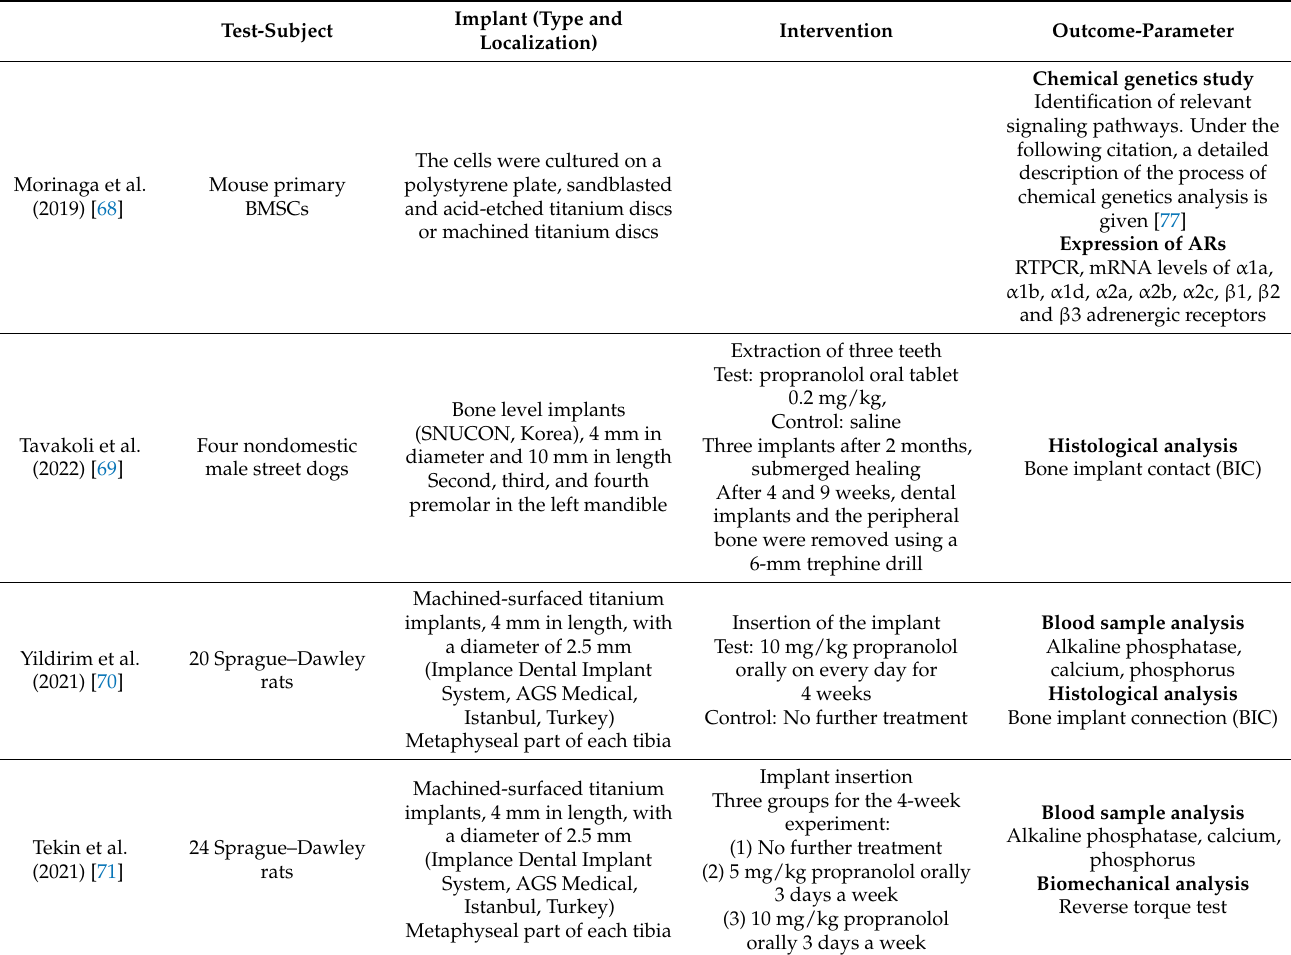
Figure 2. Risk of bias assessment according to the SYRCLE risk of bias tool [41]. H: High-risk; L: Low-risk; U: Unclear. Table 2. Preclinical